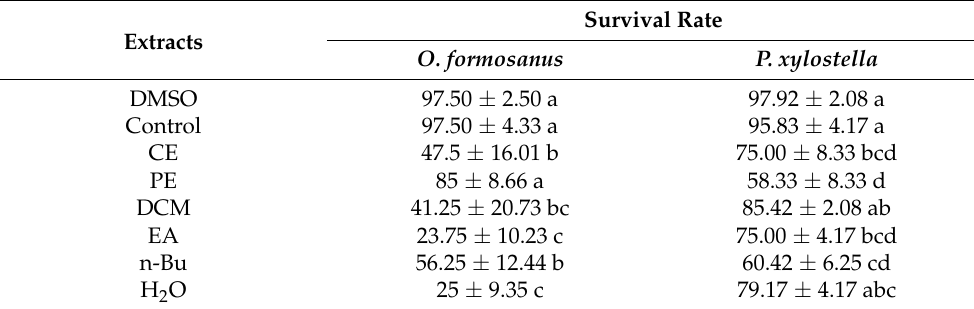
Table 1. Insecticidal activity of different tung meal extracts on O. formosanus and P. xylostella .